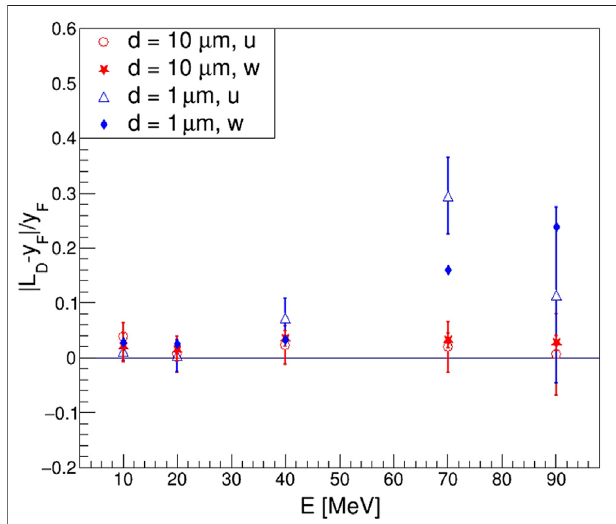
FIGURE 9 | Relative residuals of (cid:1) L D from (cid:1) y F for the different site diameters and sampling methods considered.